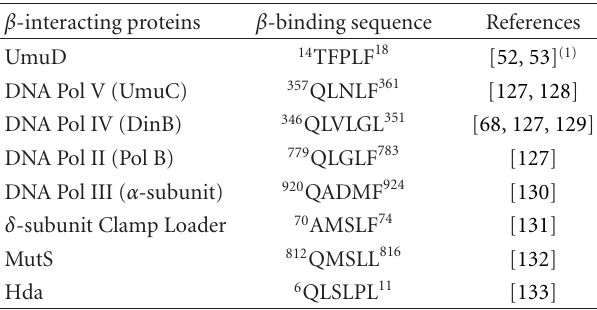
Table 1: E. coli proteins that interact with the β clamp via the β - binding pentapeptide motif QL[SD]LF or similar sequence